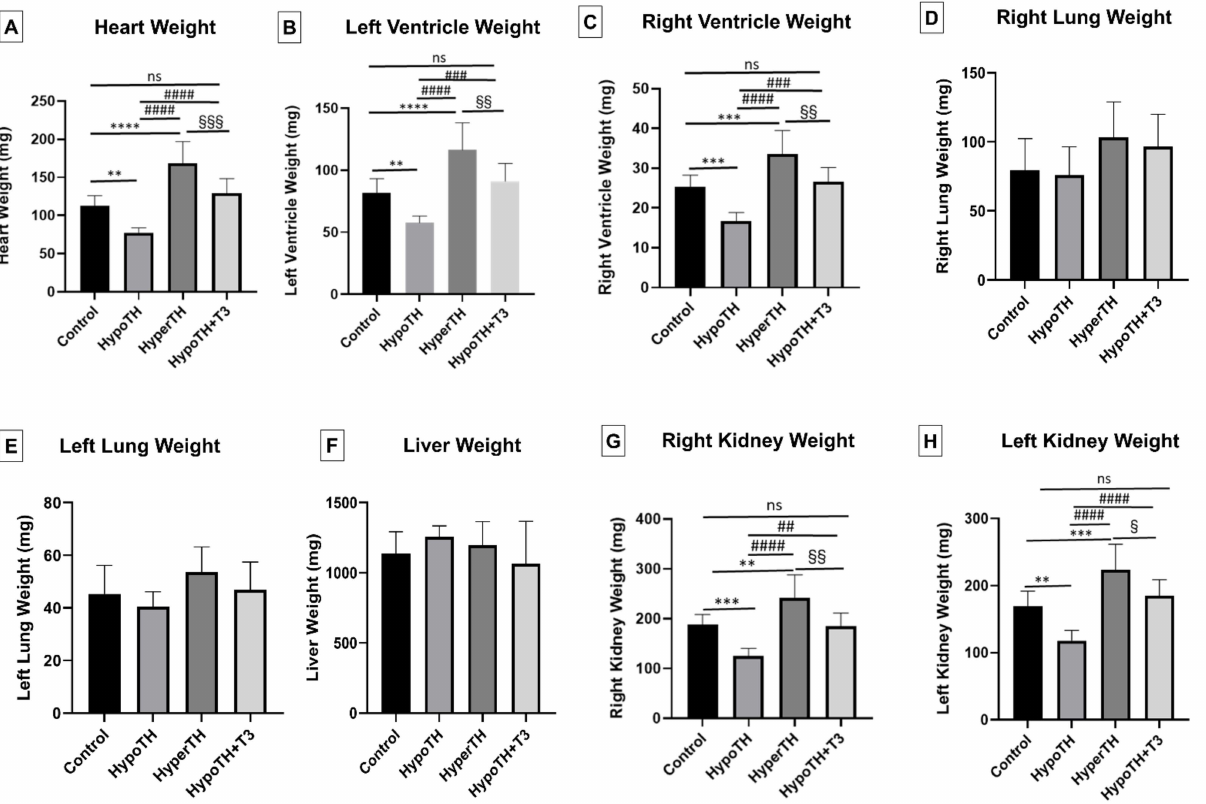
Figure 2. Morphometrics under altered TH states (all mice): Alterations in ( A ) Heart, ( B ) Left Ventricle, ( C ) Right Ventricle, ( D ) Right Lung, ( E ) Left Lung, ( F ) Liver, ( G ) Right Kidney, ( H ) Left Kidney weights of mixed sex mice when subjected to HypoTH, HyperTH, and restoration in the HypoTH group following oral T3. All values are means ± standard deviation; n = 8–10 per group. TH–thyroid hormone; HyperTH: Hyperthyroidism; HypoTH: Hypothyroidism; T3: Triiodothyronine; ** p < 0.01, *** p < 0.001, **** p < 0.0001 vs. controls; ## p < 0.01, ### p < 0.001, #### p < 0.0001 vs. HypoTH; § p < 0.05, §§ p < 0.01, §§§ p < 0.001 vs. HyperTH; ns: not